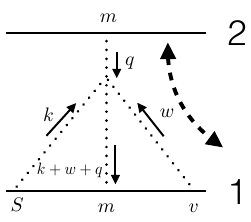
Figure 5 . One of the other leading contributions to the e(cid:11)ective potential from ~ \peace/log" topology. The dashed arrow indicates contraction of indices within ~